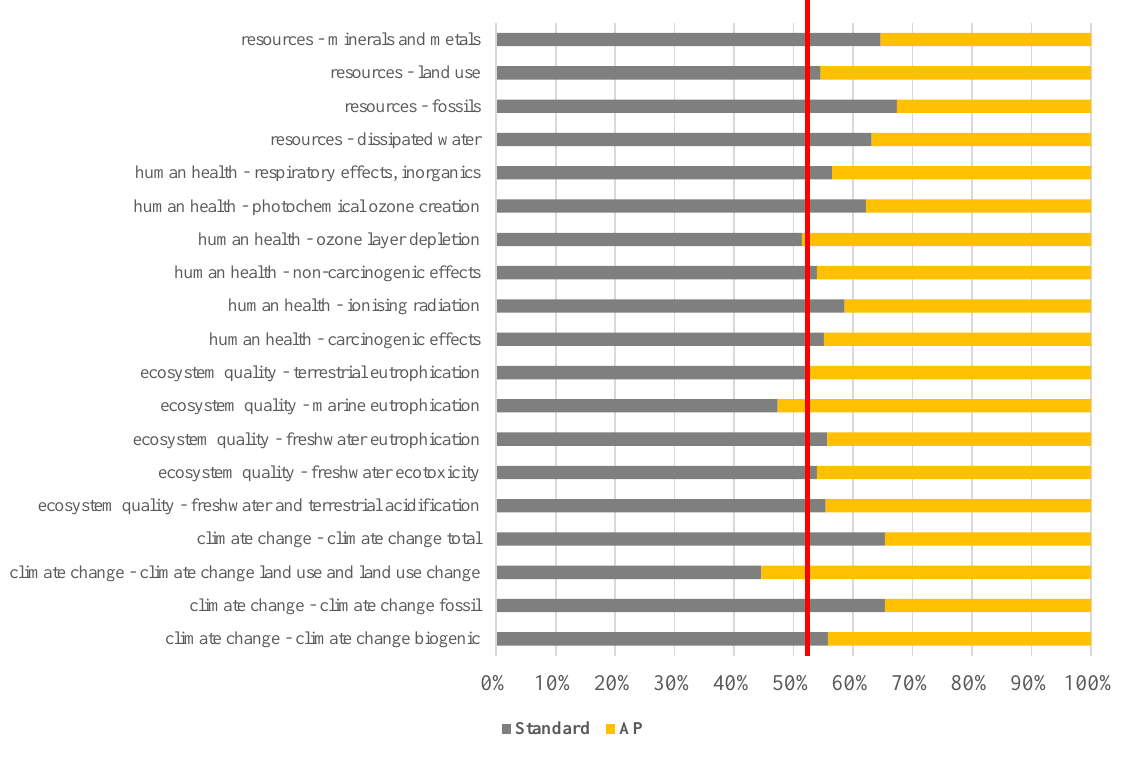
Figure 5. Contribution of standard product and AP product to LCA’s impact categories .